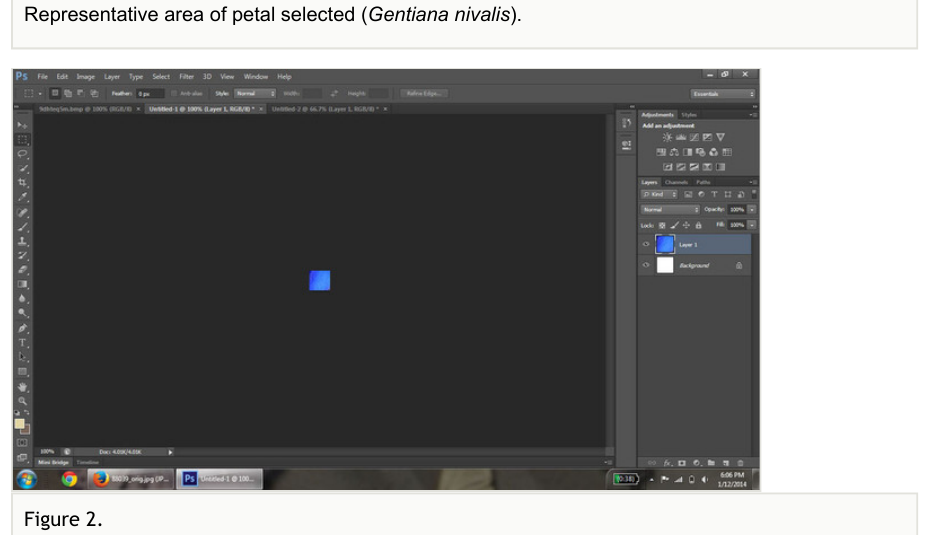
Representative area of petal selected ( Gentiana nivalis ).